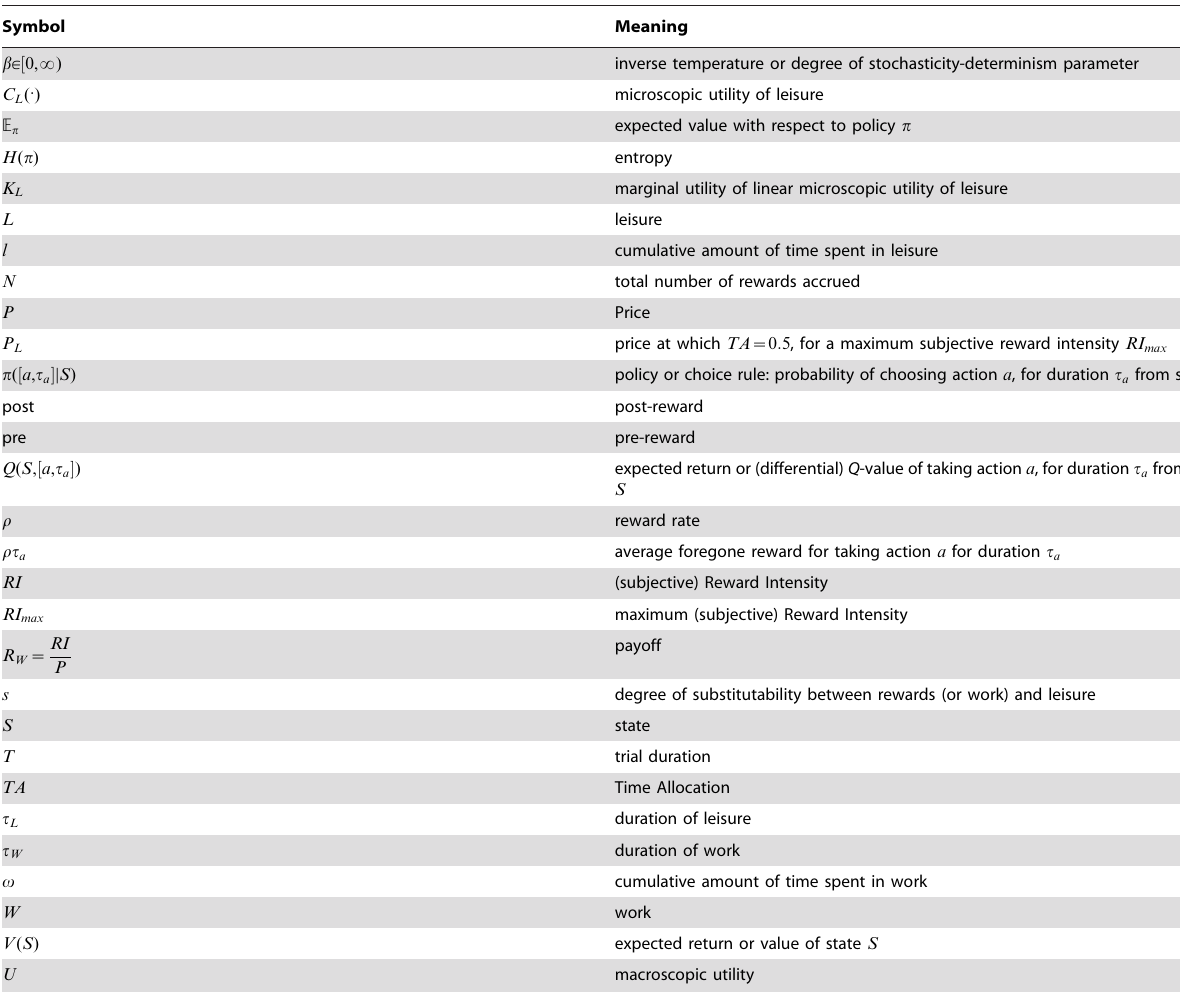
Table 1. List of